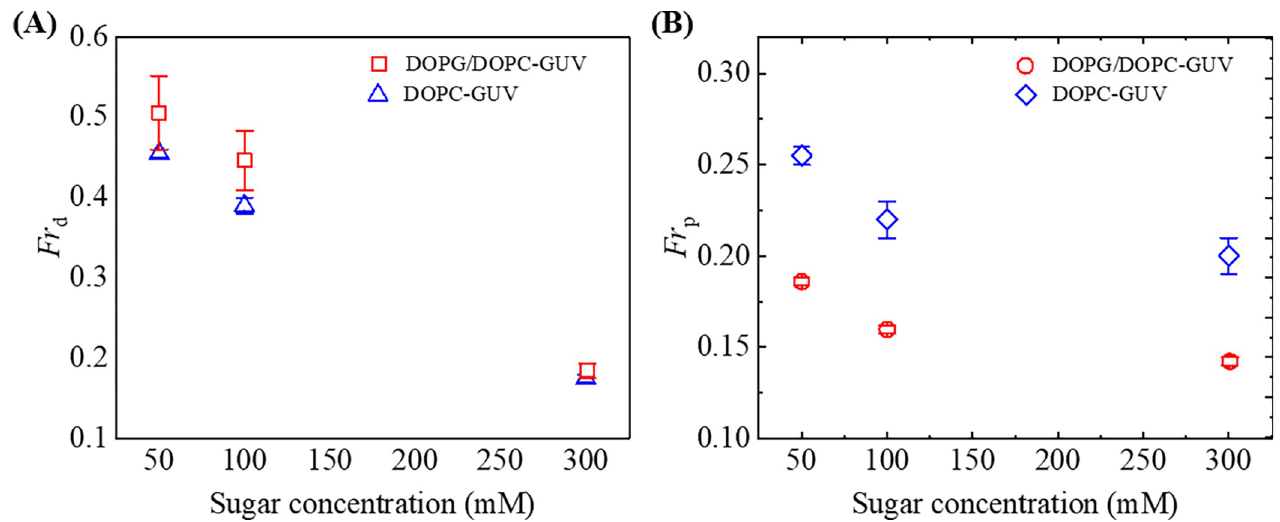
Fig 7. Comparison between the fraction of deformed and pore formed 40%DOPG/60%DOPC-GUVs and DOPC-GUVs under various sugar concentration at 3.33 μ g/mL NPs. (A) The sugar concentration-dependent Fr d for 40%DOPG/60%DOPC-GUVs and DOPC-GUVs at 40 min. (B) The sugar concentration-dependent Fr p for 40%DOPG/60%DOPC-GUVs and DOPC-GUVs at 40 min. The average values with standard deviations were obtained from 3 independent experiments containing 15–20 GUVs in each independent experiment.